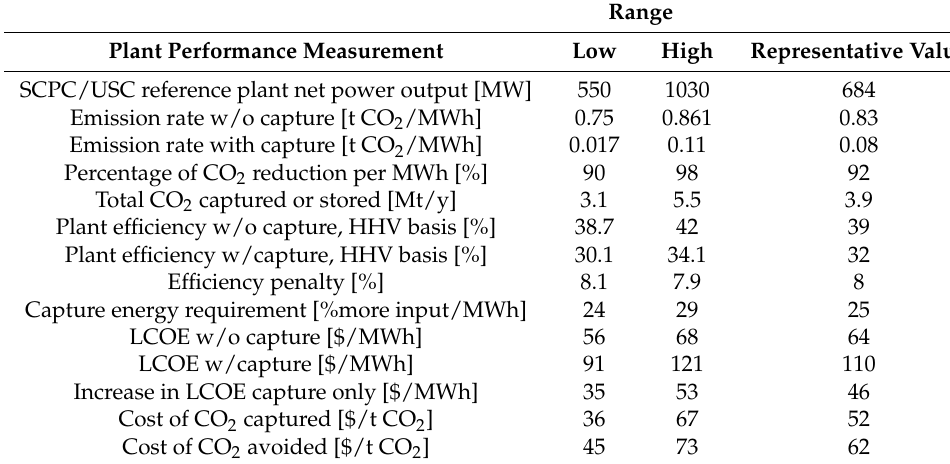
Table 1. Current performance and cost estimates for oxyfuel combustion capture at new (SCPC/USC) plants (values in 2013 US$) [21]. Definition: Higher Heating Value